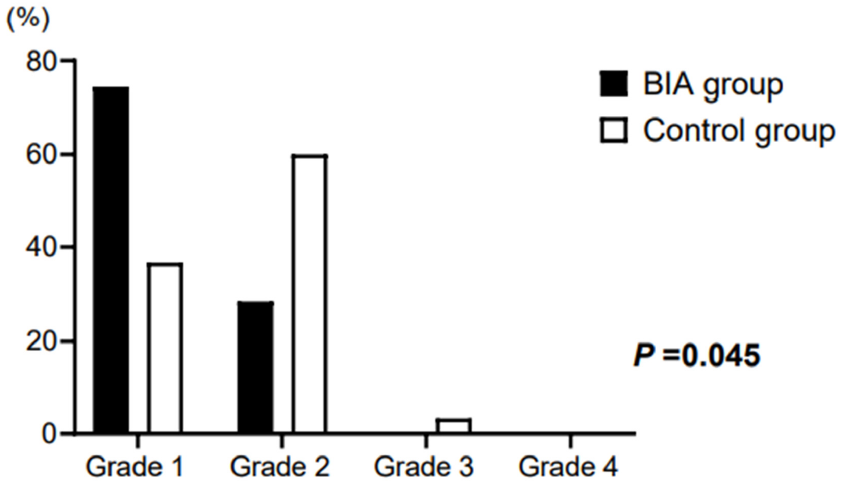
Figure 3. Surgical field grade of patients. In the BIA group, grade 1 (71.4%) was the most common, followed by grade 2 (28.6%). In the control group, grade 2 (60.0%) was the most common, followed by grade 1 (36.7%) and grade 3 (3.6%) ( p = 0.045). BIA, bioelectrical impedance analysis.